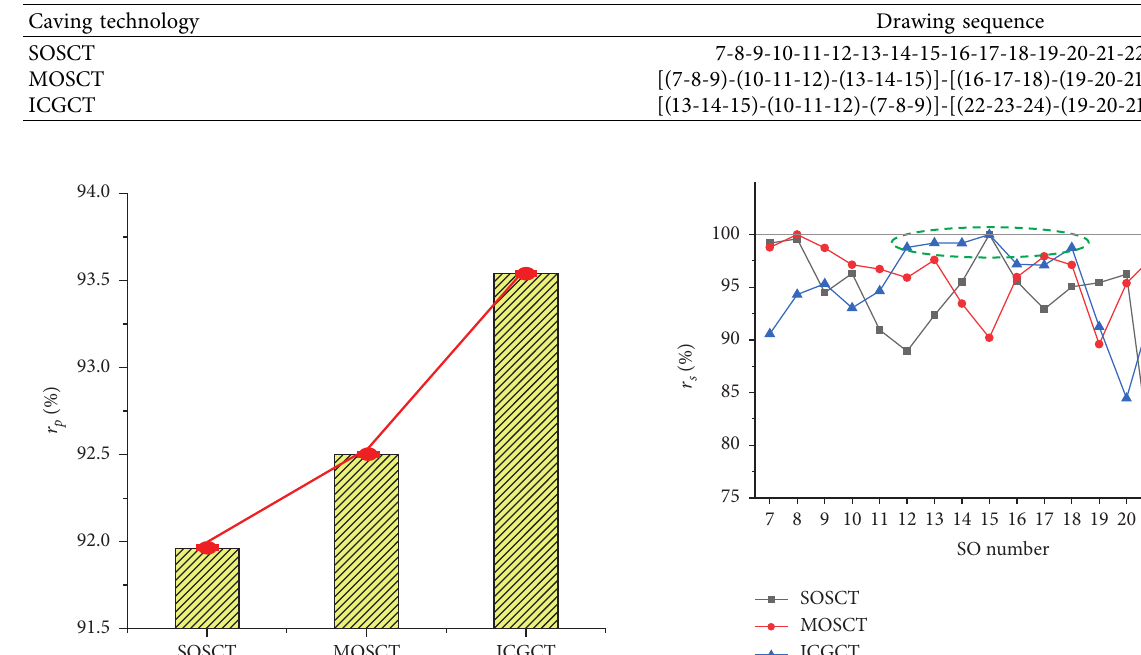
Table 2: The designed experimental schemes.